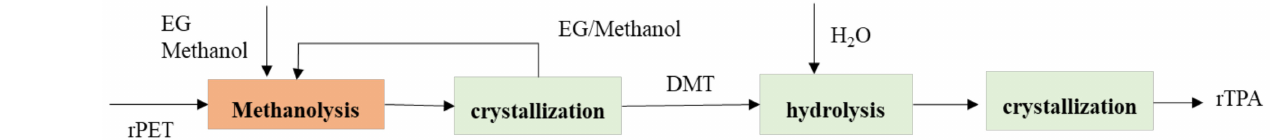
Figure 7. The process of PET recycling with methanolysis–crystallization-hydrolysis.